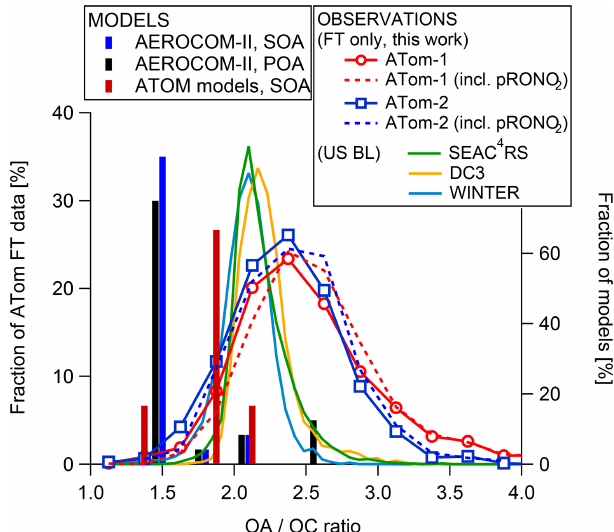
Figure 5. Distribution of the OA / OC ratio as measured during ATom-1 and ATom-2. Values for the recent aircraft campaigns (SEAC4RS, DC3, and WINTER) that took place over continen- tal US regions closer to continental source regions are also shown (Schroder et al., 2018). The bars (right axis) show the OA / OC used for SOA and POA by the models included in the AeroCom and ATom ensemble, with OA / OC = 1 . 4 being the modal value for the former and 1.8 for the